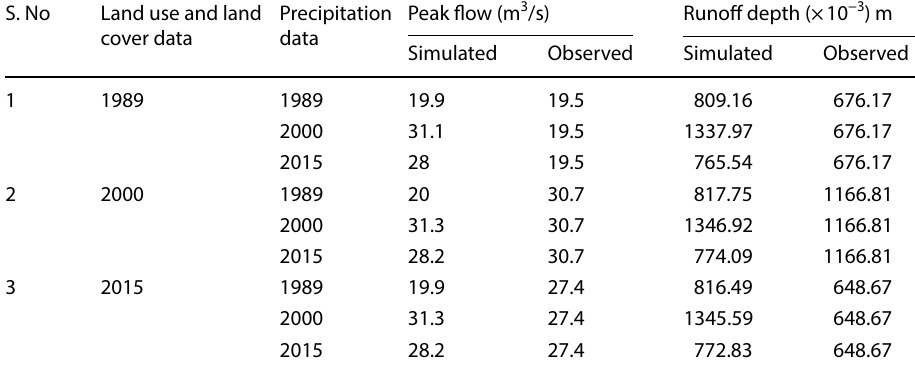
Table 12 Simulated annual surface runoff in different scenarios